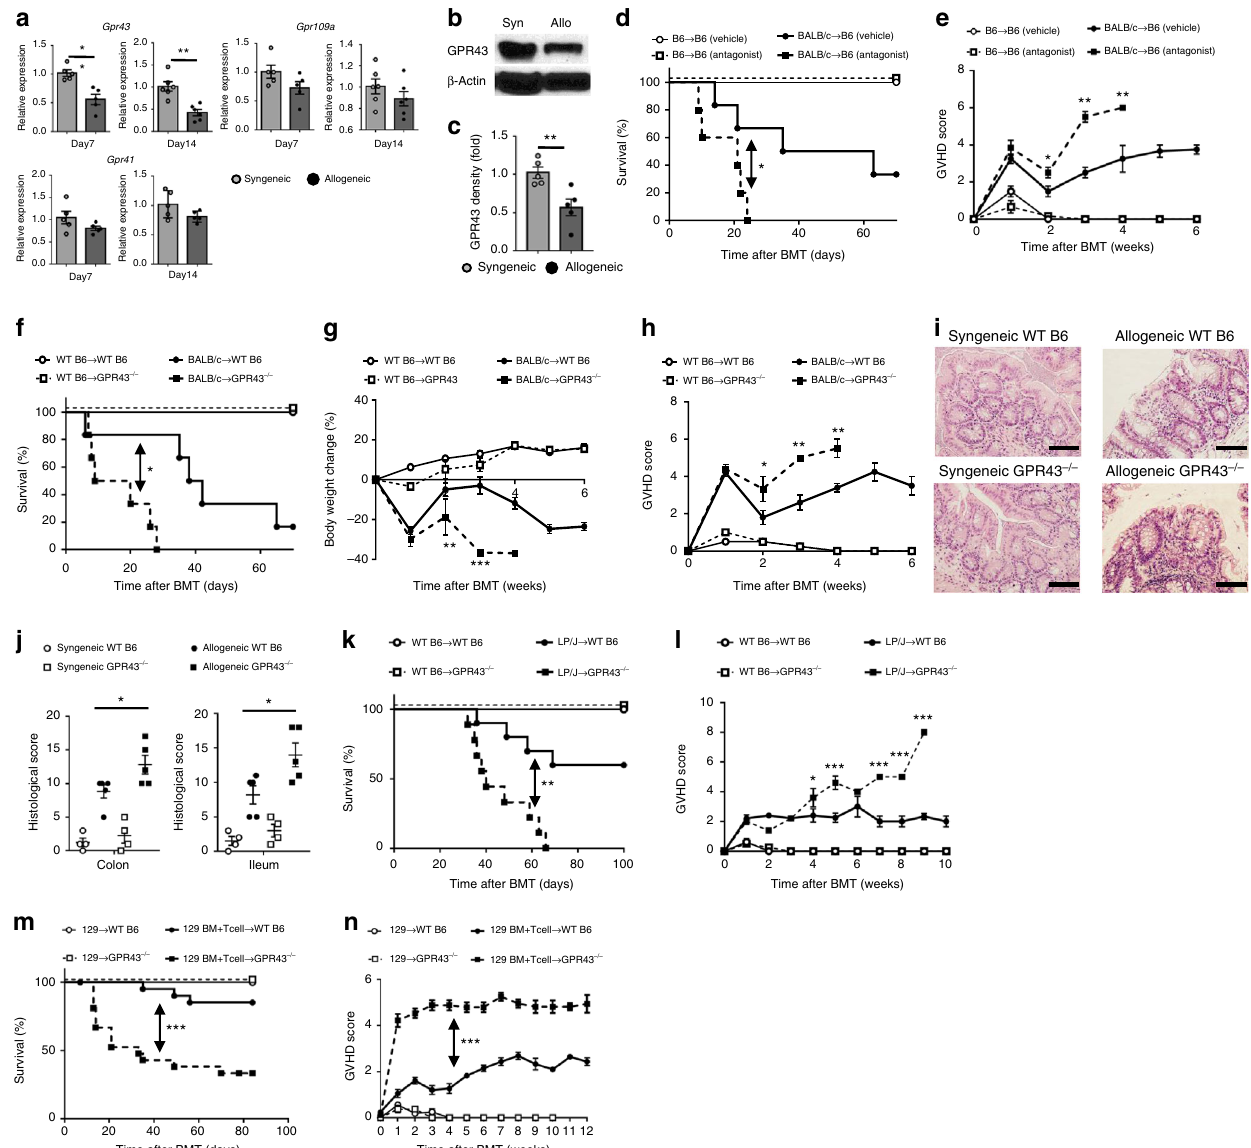
Fig. 1 GPR43 protects against GVHD. B6 WT and Gpr43 − / − mice received BMT from either syngeneic B6 or allogeneic BALB/c donors. a Gene expression of GPR43 , GPR41 , and GPR109a in IECs (CD326 + ) from syngeneic and allogeneic WT B6 recipients 7 and 14 days after BMT ( n = 5 in Day 7, n = 6 in Day 14, two-tailed Mann – Whitney U test). b , c Representative immunoblots and densitometric analysis of GPR43 normalized to the presence of β -actin in IECs (CD326 + ) from syngeneic and allogeneic WT B6 recipients 14 days after BMT ( n = 5 each, two-tailed Mann – Whitney U test). d , e Survival and clinical GVHD score after BMT treated with intragastric vehicle or GPR43 antagonists (10 mg kg − 1 per day) from day 0 to day 21 ( n = 3 each syngeneic, n = 6 allogeneic-vehicle, n = 5 allogeneic-antagonist, log-rank test for survival, two-tailed Mann – Whitney U test for GVHD Score). f – h Survival, weight change, and clinical GVHD score after BMT ( n = 3 each syngeneic, n = 6 each, log-rank test for survival, two-tailed unpaired t -test for body weight change and two- tailed Mann – Whitney U test for GVHD Score). i , j Representative H&E stained colonic sections and histopathological GVHD score in colon and ileum from WT B6 or Gpr43 − / − recipients on day 14 after BMT (scale bar, 100 μ m) ( n = 4 each syngeneic, n = 5 each allogeneic, two-tailed Mann – Whitney U test). k , l WT B6 and Gpr43 − / − mice received BMT from either syngeneic B6 or allogeneic LP/J donors. Survival and clinical GVHD score after BMT ( n = 5 each syngeneic, n = 10 each allogeneic, log-rank test for survival, two-tailed Mann – Whitney U test for GVHD Score). m , n WT B6 and Gpr43 − / − mice received BMT from 129S1 donors. Survival and clinical GVHD score after BMT (129S1 BM to WT B6; n = 4, 129S1 BM to Gpr43 − / − ; n = 3, 129S1 BM + T cells to WT B6; n = 21, 129S1 BM + T cells to Gpr43 − / − ; n = 15, log-rank test for survival, two-tailed Mann – Whitney U test for GVHD Score). Data are representative